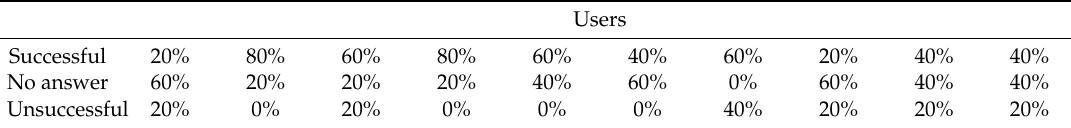
Table 6. Successful answer, no answer and unsuccessful answer ratios in flat design.